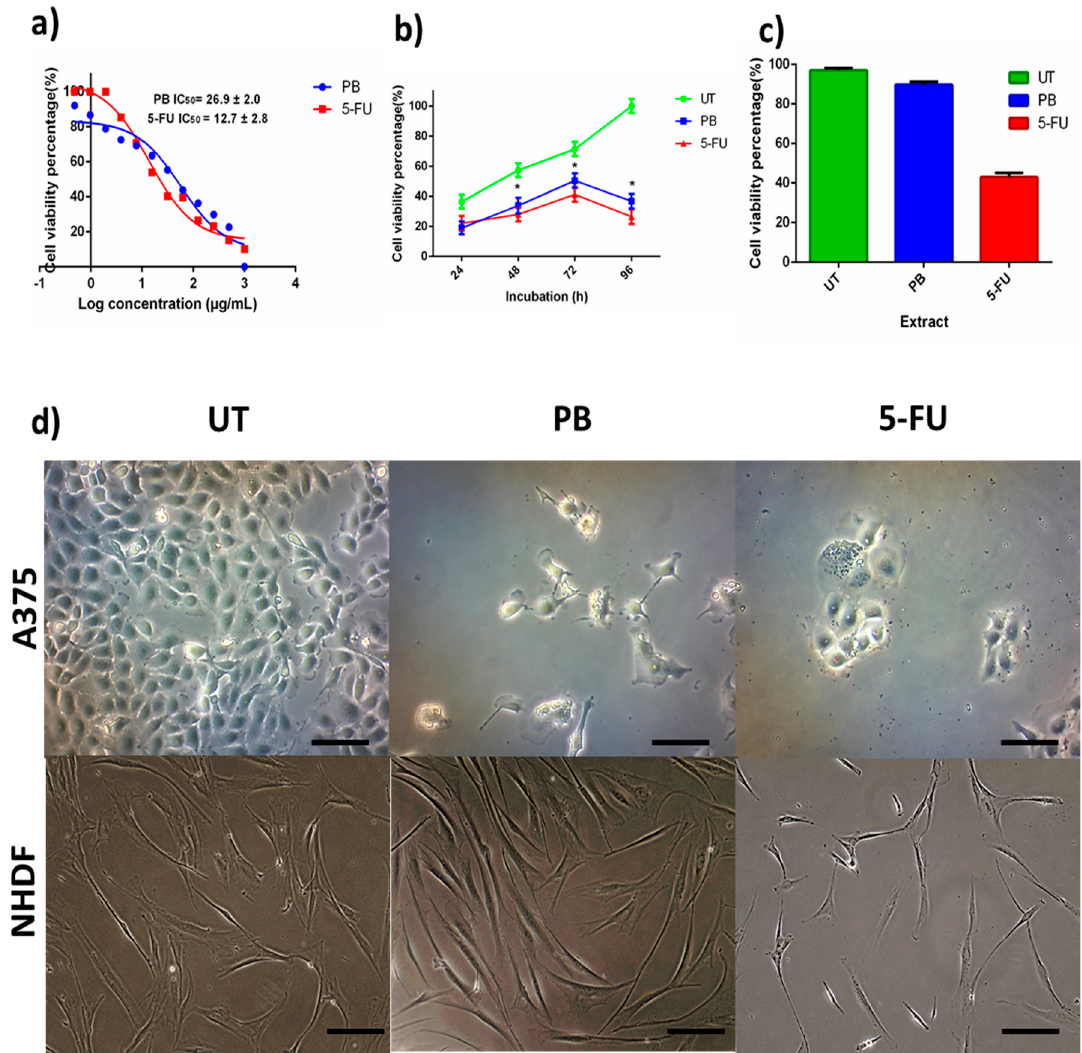
Figure 4. The effect of PB aqueous extract on A375 cells viability. ( a ) Median concentration of A375 treated with PB aqueous extract and 5-fluorouracil (5-FU). Graph shown are after the exposure with treatment for 72 h. IC 50 is presented in mean ± SD ( n = 3). ( b ) Anti-proliferative effect of PB aqueous extract at 24, 28, 72, and 96 h with untreated cells (UT) and 5-FU as controls. ( c ) Cytotoxic effect of median concentration on normal human dermal fibroblast (NHDF) cells at 72-h incubation. ( d ) Image of A375 and NHDF cells upon treatment with PB aqueous extract, UT, and 5-FU for 72 h. Bar graph = 25 µm. * indicates p <0.01.